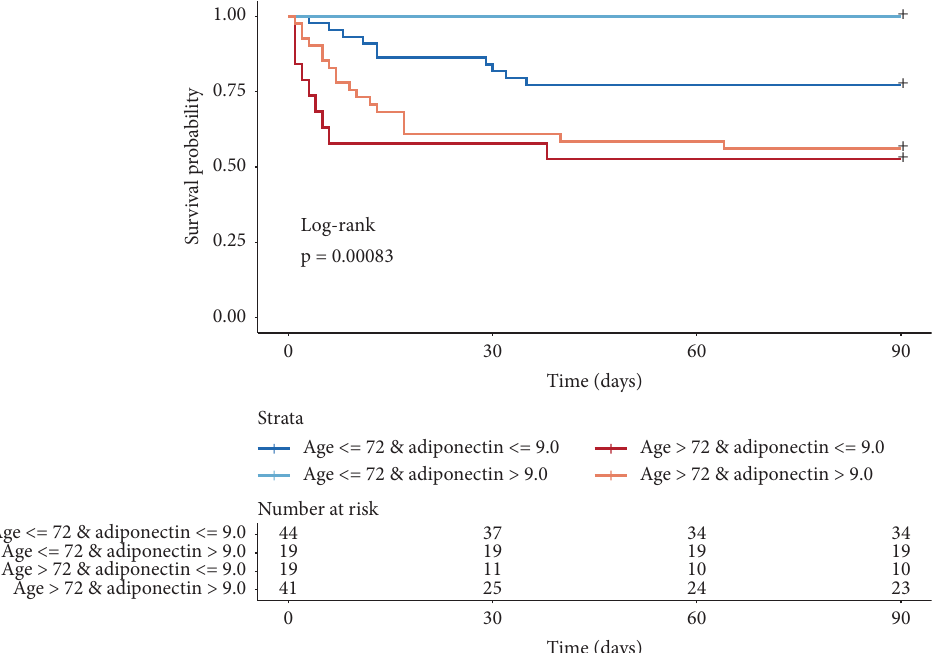
Figure 2: Cumulative estimate survival probability stratifed by median age (72years) and median adiponectin level (9.0 μ g/mL) of patients hospitalized with COVID-19. Statistics performed by log rank test for equal mortality in the four groups, as